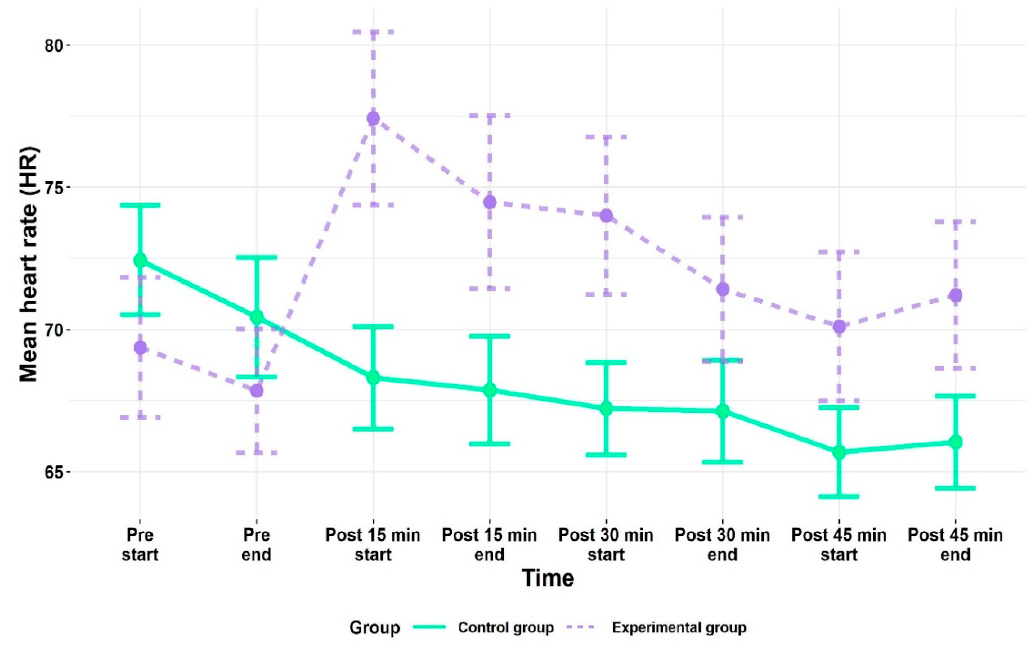
Figure 2. Mean heart rate (HR) values for the experimental (EG) and control group (CG) before (pre) and post-exercise (follow-up measurements) for the beginning (start) and the end of each n-back task. All values are given as mean ( M ); error bars represent one standard error ( SE) of the mean.